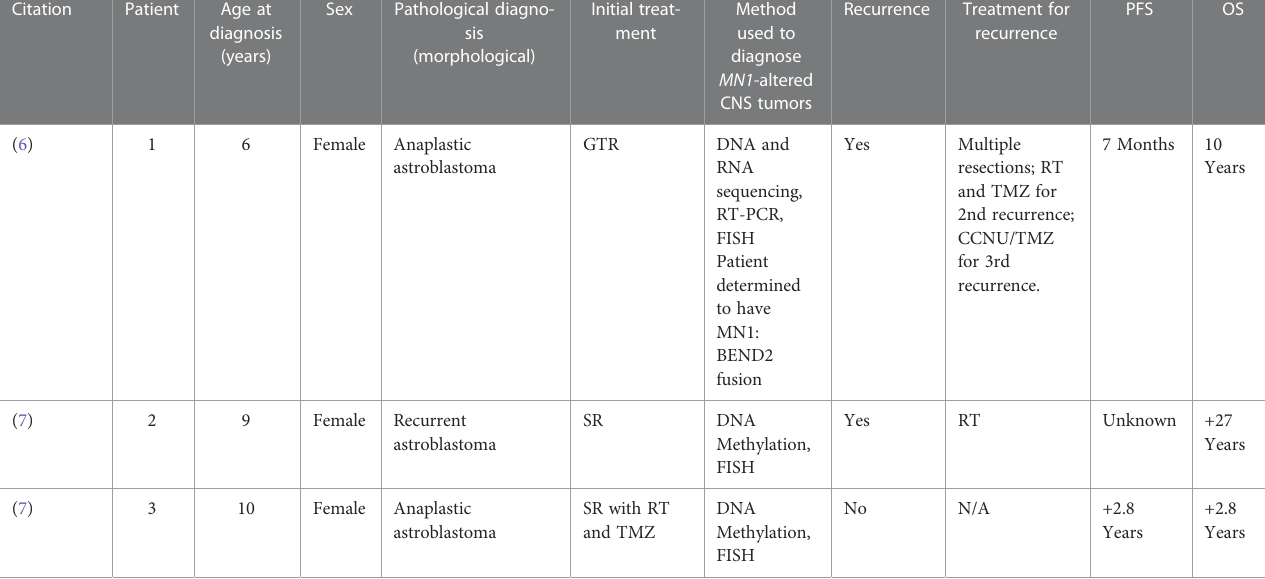
TABLE 2 Demographic, treatment, and outcome data of patients with MN1 -altered CNS tumors.